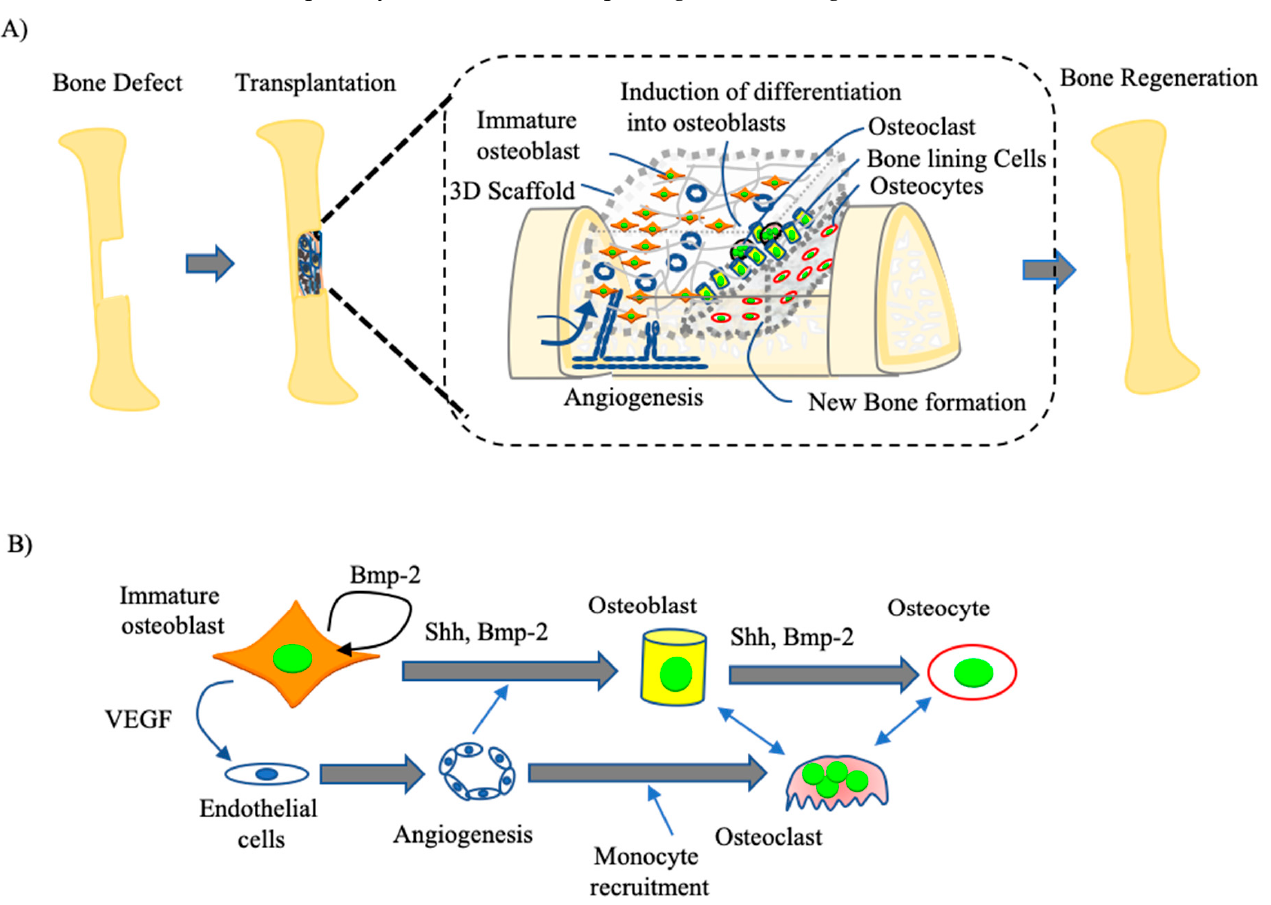
Figure 4. Schematics showing mechanisms of bone regeneration by immature osteoblasts. ( A ) Structures of the osteoblasts seeded scaffold constructs in the bone defect area following transplantation and healing of the defect site. ( B ) Molecular mechanism of bone remodeling by immature osteoblast. The immature osteoblasts under the influence of various cytokines such BMP2, SHH secreted from the bone matrix differentiate into osteoblasts. These osteoblasts produce various cell products, including enzymes alkaline phosphatase and collagenase, growth factors, osteocalcin, and collagen, part of the organic unmineralized component of bone. Few osteoblasts embed inside matrix to become osteocyte and others remain as a bone lining cells on the outer surface. Consequently, when osteoblasts lay down new matrix the osteoclast will differentiate from circulating monocytes/macrophages induced from osteoblasts secreted cytokines such as RANKL and M-CSF, as an inflammatory response to the bone defect from Osteoblasts. Simultaneously, angiogenic factors including VEGF are released from the osteoblasts to form new blood vessels.